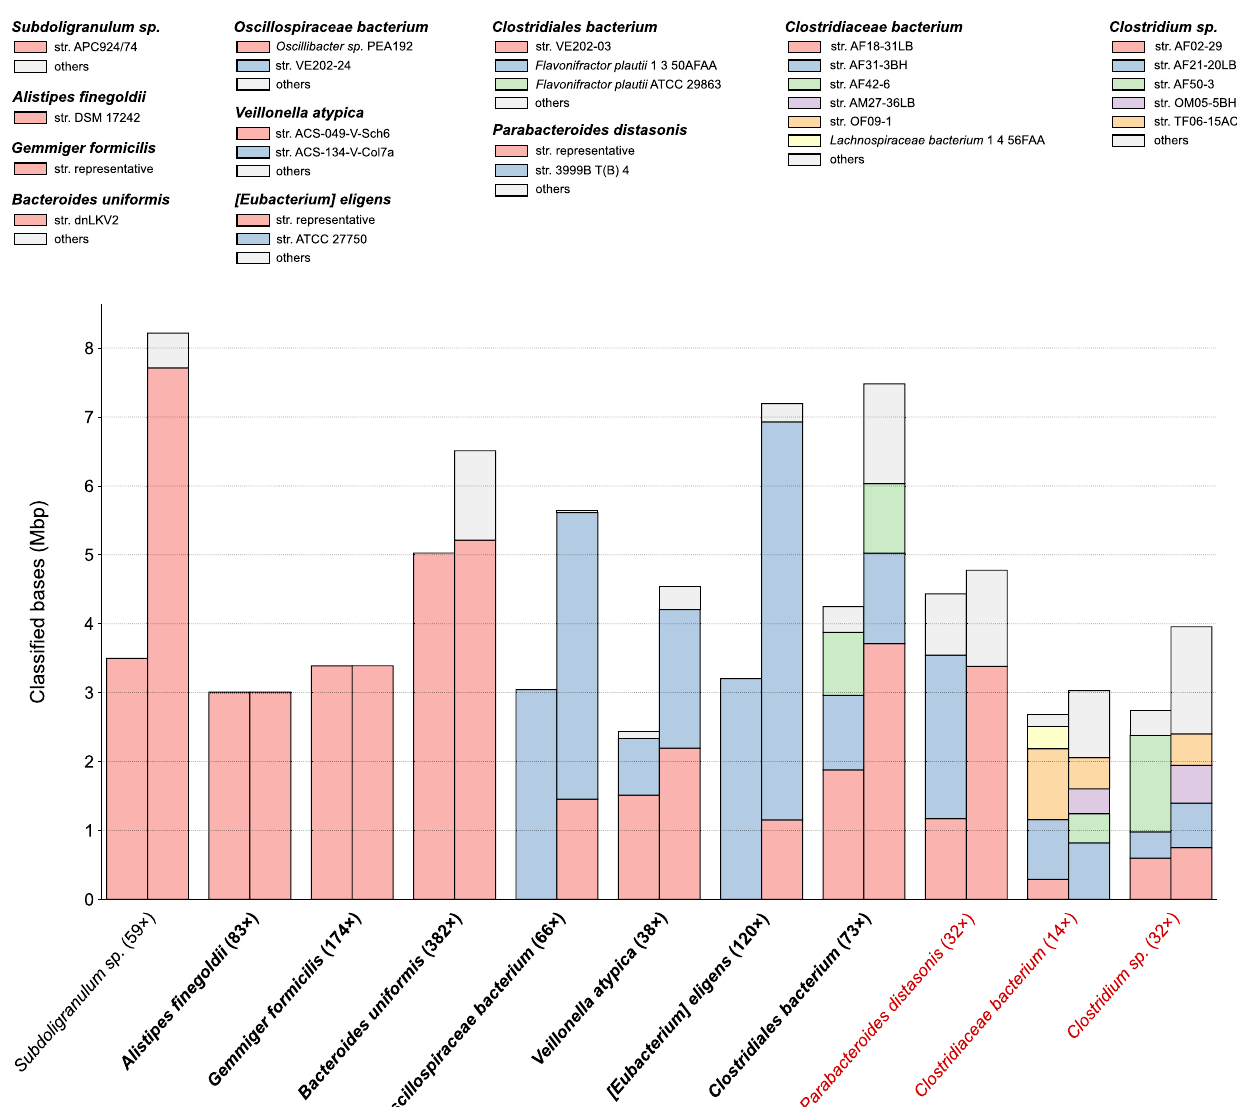
Fig. 6 Assembly size and sequence classi fi cation before and after strain separation. Bins (x-axis) are named at the species level according to the most dominant Kraken2 classi fi cation. The value between parentheses represents the average depth of coverage of the bin before the strain separation. Bins highlighted with a bold font have a moderate post-separation completeness (>70%), while those highlighted in red have either poor completeness (<50%) or low read coverage (<30×). Colored bars represent the number of bases classi fi ed as a speci fi c species/strain in a bin before and after the strain separation (left and right-hand bars, respectively). Classi fi ed sequences whose size accounts for less than 10% of the bin size have been grouped as “ others ”